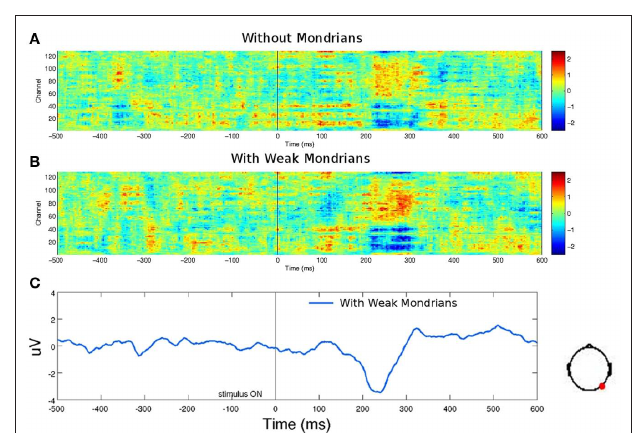
FiGurE 6 | EEG signal-to-noise ratio of targets. (A) Low luminance targets (animals and tools together) generated a reliable EEG response when presented to one eye without Mondrians to the other eye, and (B) with low luminance Mondrians in the dominant eye. Six subjects participated in this control experiment. (C) One occipital channel from (B) is shown as an example of the components generated by low luminance targets. For both conditions (A,B) , subjects were above 95% accuracy at discriminating the category of the stimuli and reported seeing the stimuli without difficulty. The absence of an EEG response to unseen targets ( Figure 4 ) cannot be explained by low signal-to-noise ratio of low